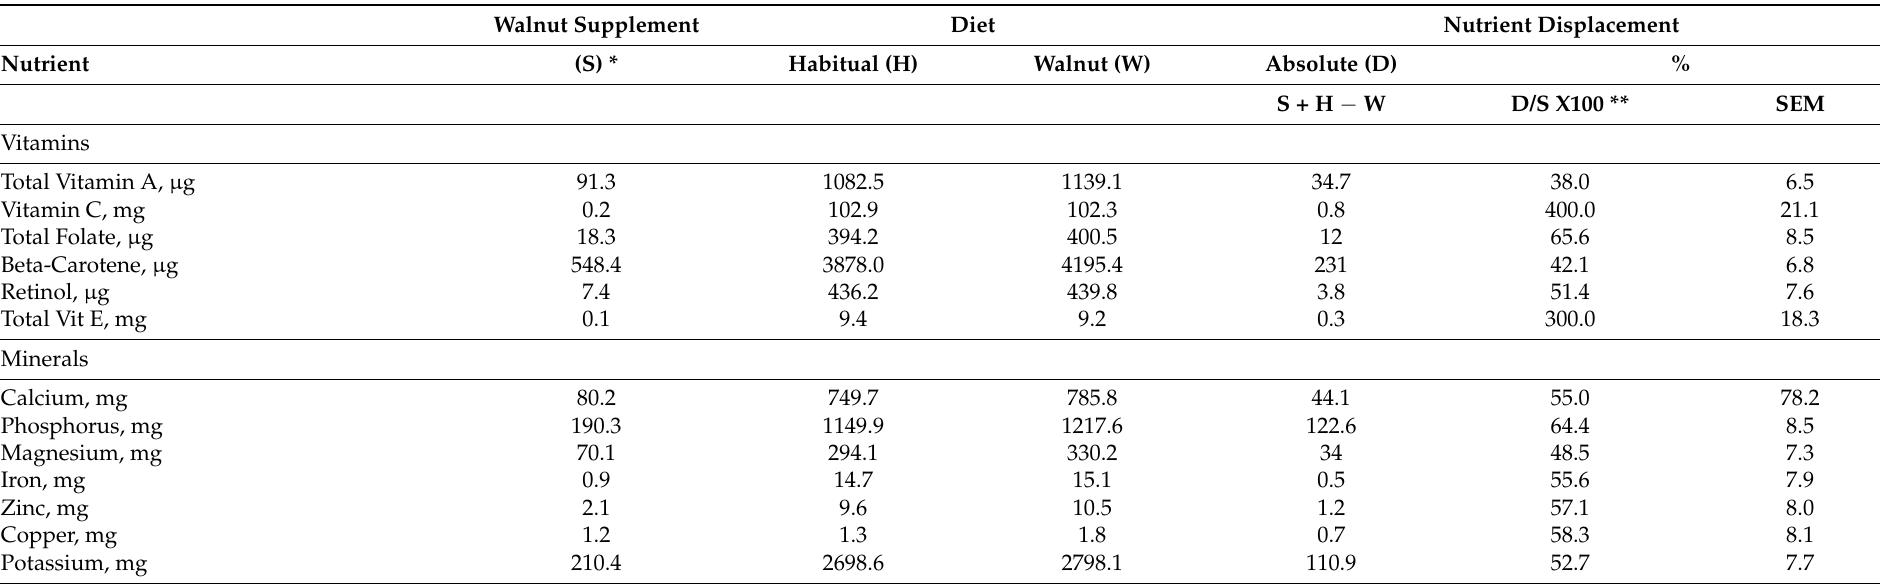
Table 6. Displacement of specific micronutrients after 6 months of walnut supplementation. All values are means of reported intake on 7 24-h